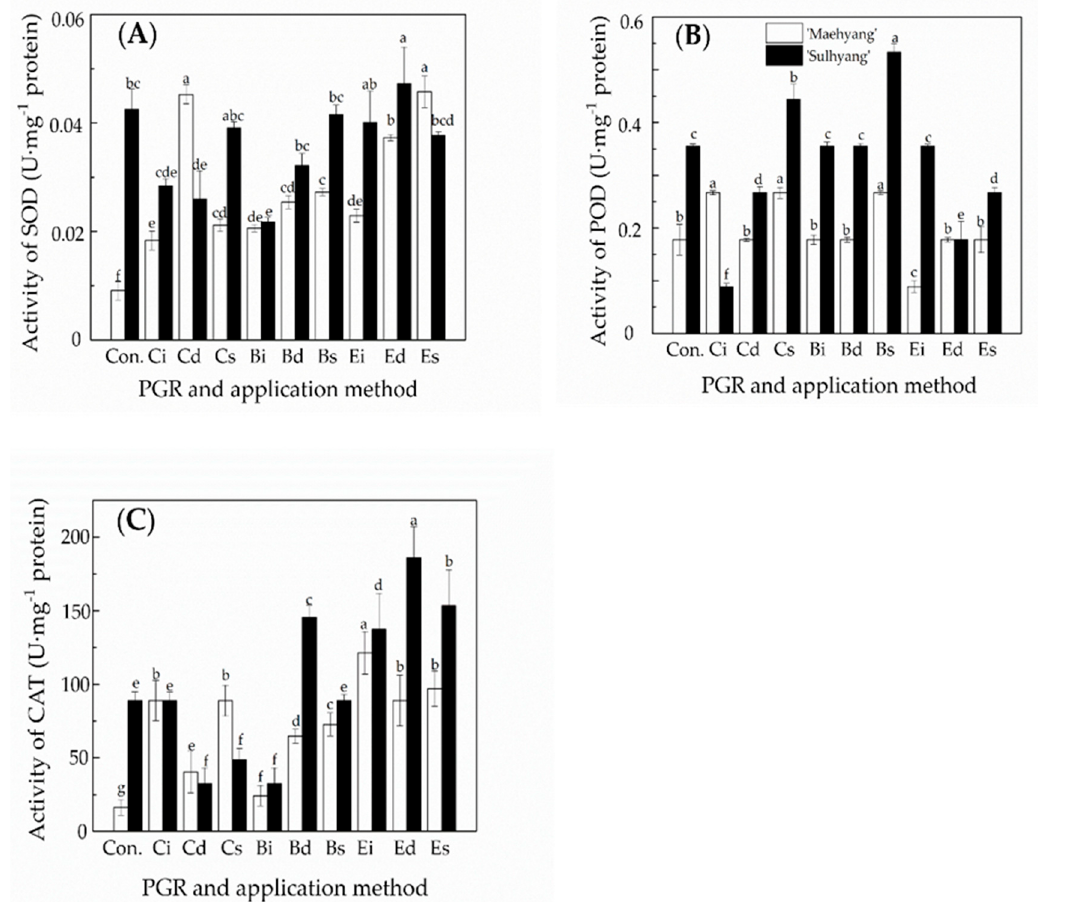
Figure 3. The effects of the chlormequat chloride (CCC), 6-benzylaminopurine (BA), and ethephon